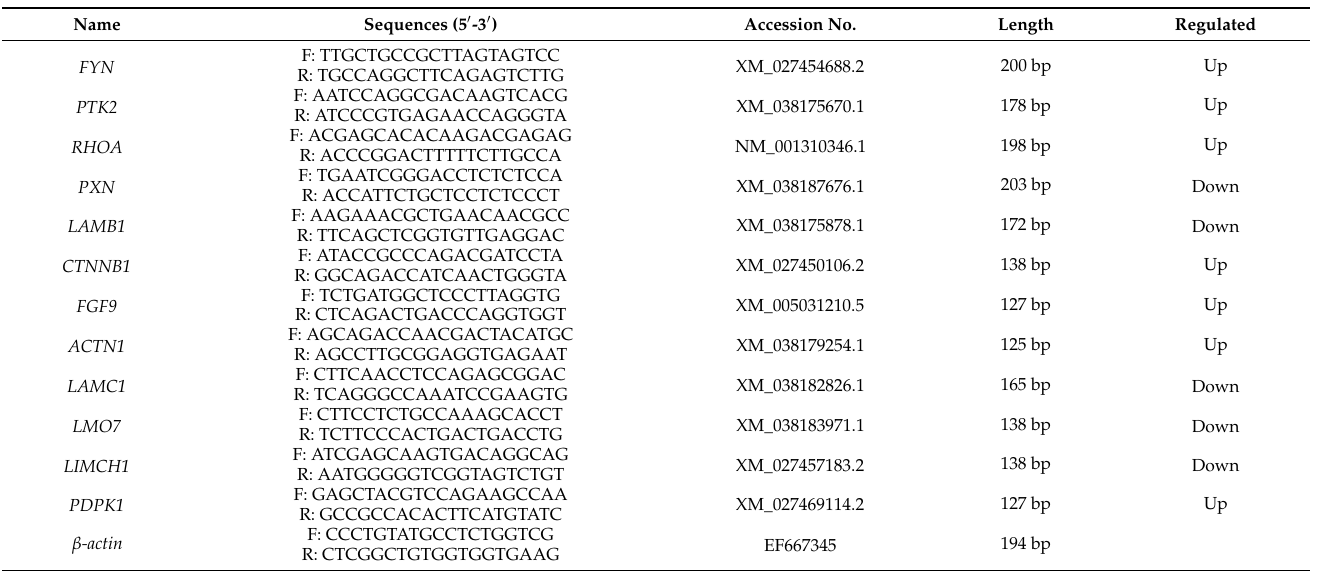
Table 5. Primers used for RT-qPCR